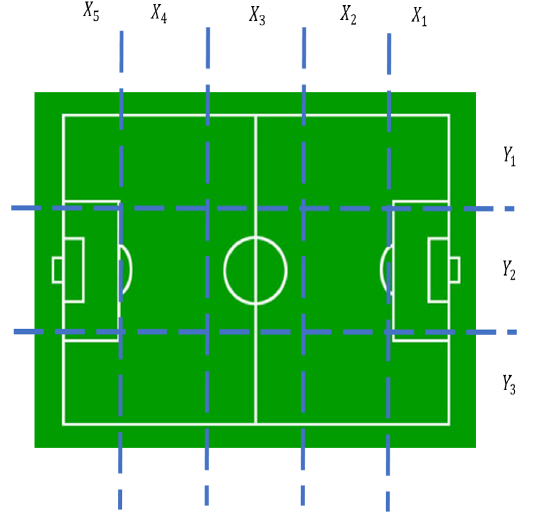
Figure 1. Divisions of the soccer field in the X and Y